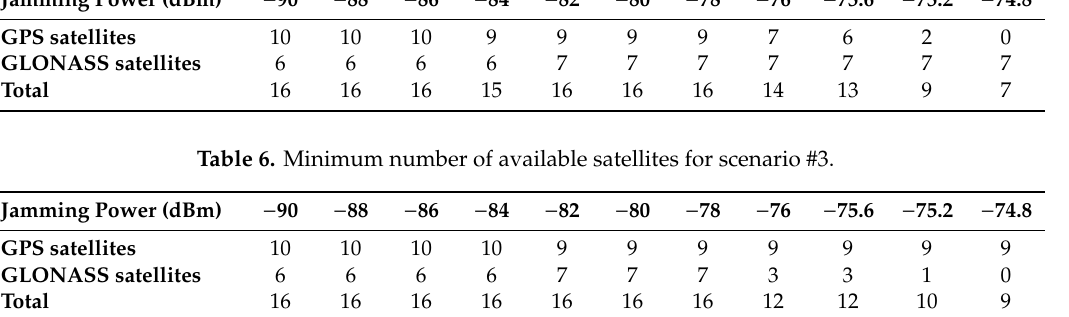
Figure 9. Average carrier-to-noise ratio of scenario #2. ( Top figure )—GPS measurements; ( bottom figure )— GLONASS measurements.